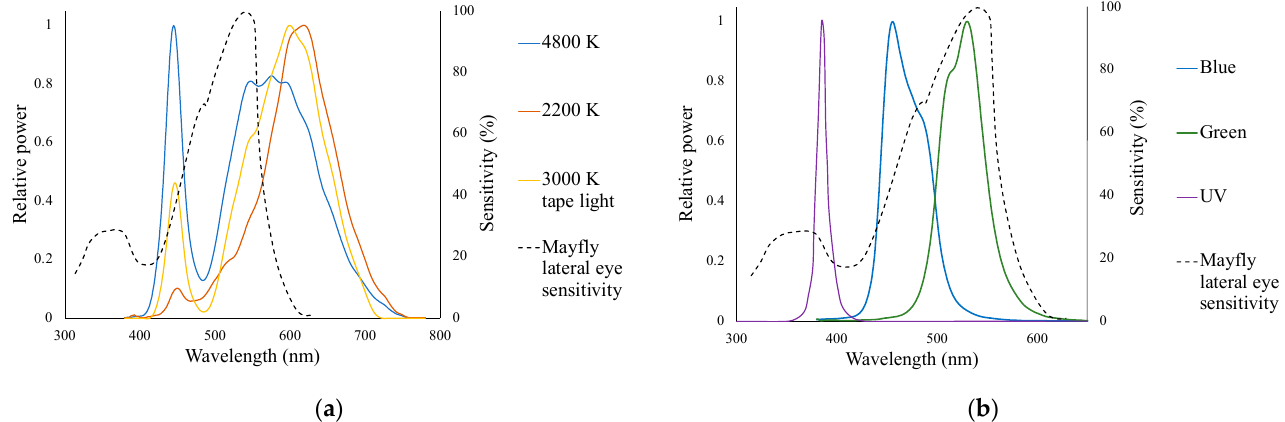
1 Light intensity was reduced by turning off the light sources at the north side of the bridge; 2 Provided by parapet walls; 3 Green and blue polarized light; 4 Tape light along roadside of parapet wall; 5 Green light; 6 House sides of roadway luminaires were blocked with cardboard.